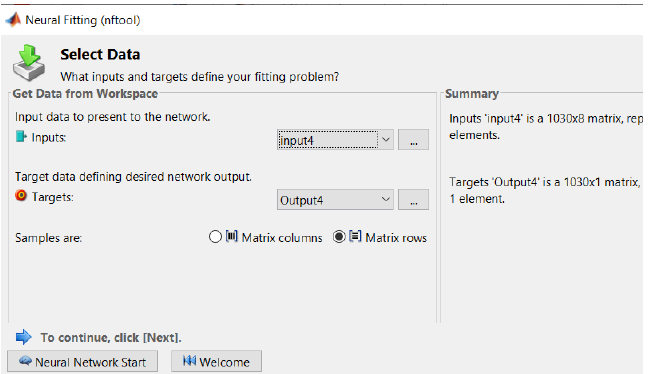
Figure 4. Selecting input and output (Target) matrix.